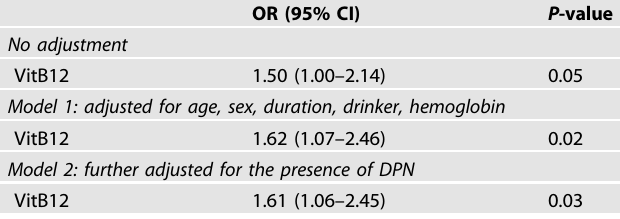
Table 3. Associations between the VitB12 and the presence of insomnia in T2DM patients in different Logistic Regression Models.